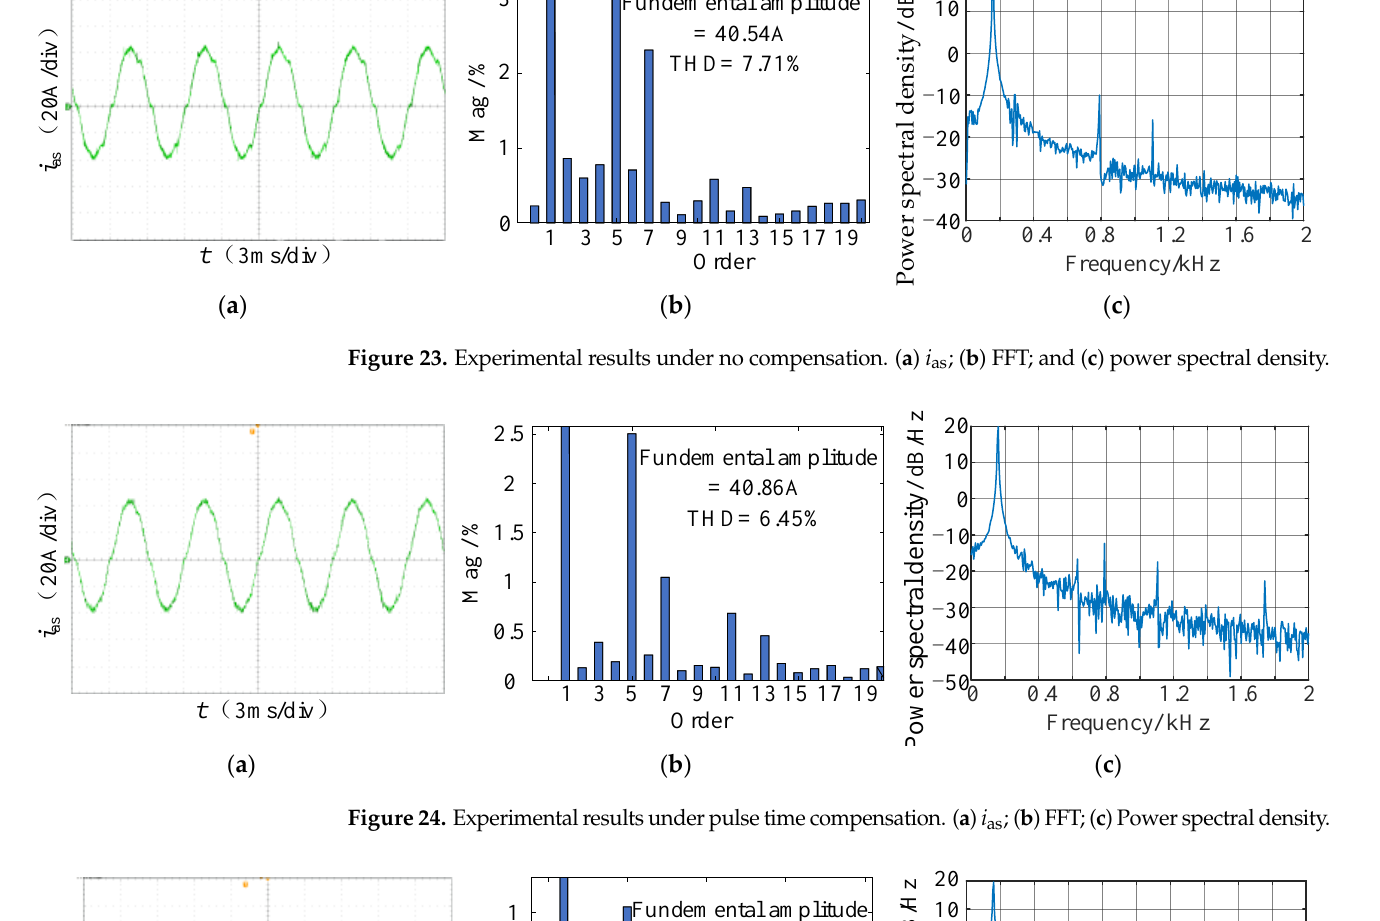
Figure 22. Experimental prototype.